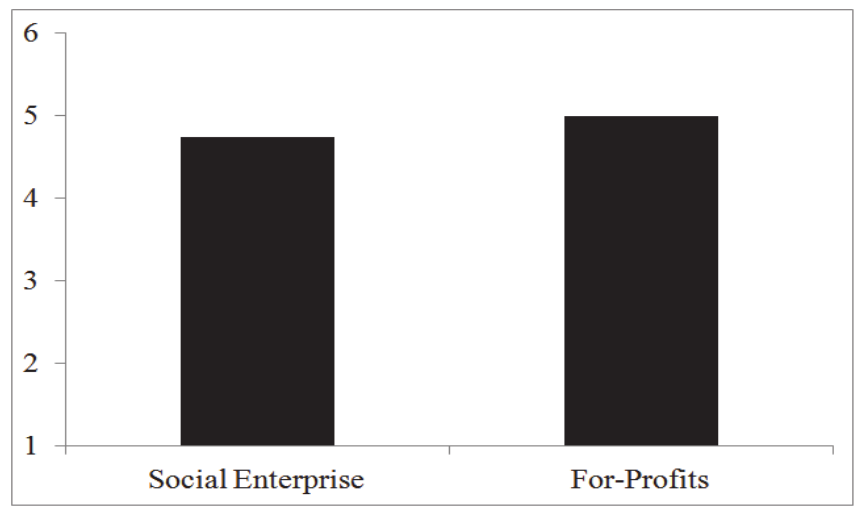
<Figure 3> Willingness to Buy as a Function of the Enterprise